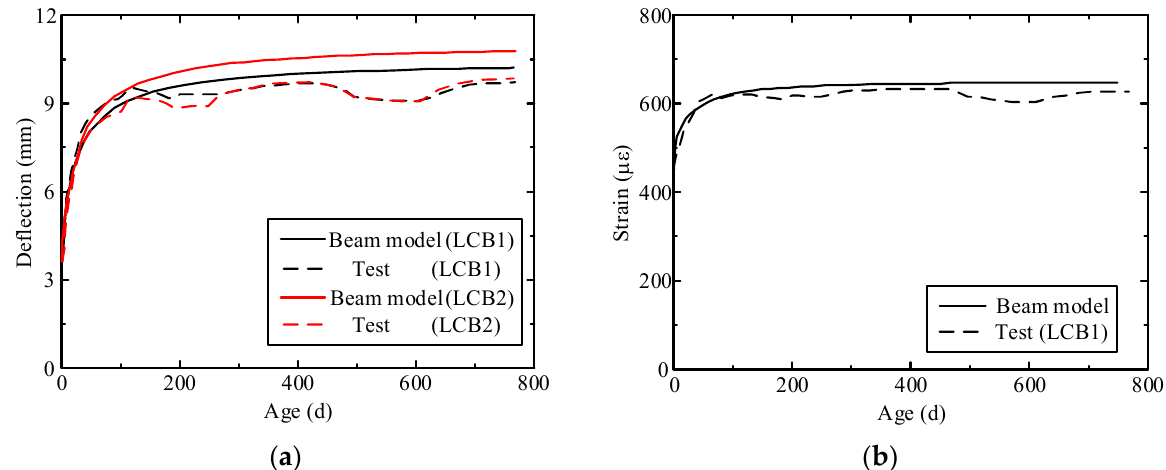
Figure 7. Comparison of the experimental results in [38] and the results of prediction for the finite beam element model. ( a ) Vertical deflection; ( b ) Normal strain of steel bottom flange (Adapted with permission from Ref. [35]. Copyright 2017 Elsevier.).